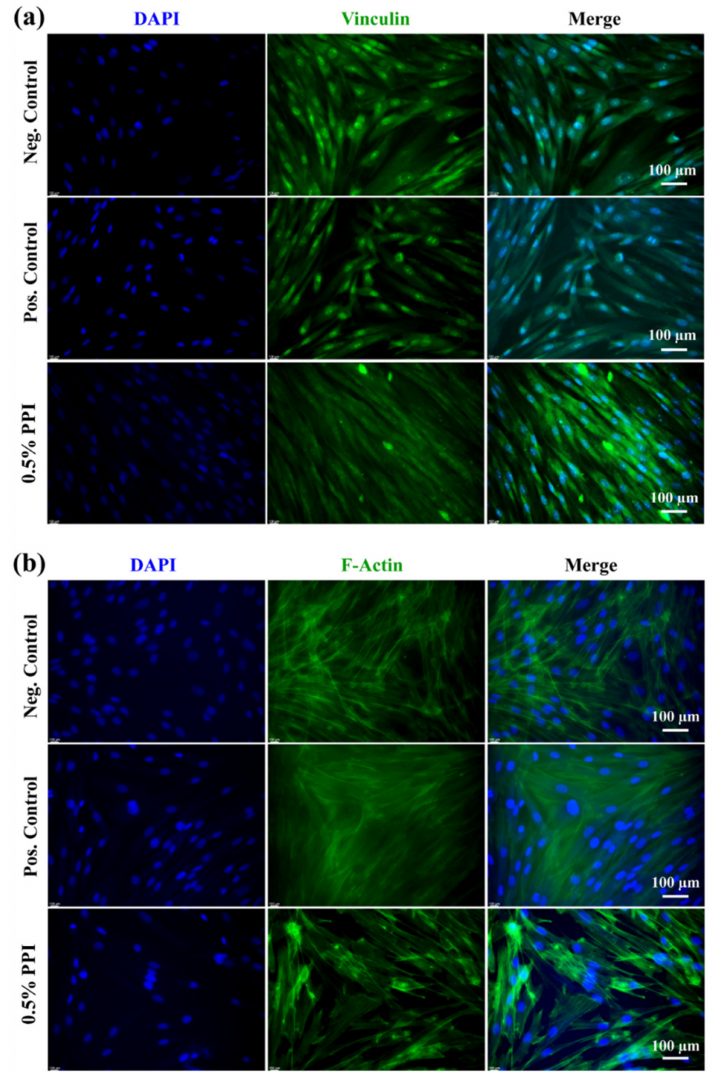
Figure 6. Morphology of PPI-treated hBMSCs after three days of incubation. Fluorescence images of ( a ) vinculin and ( b )